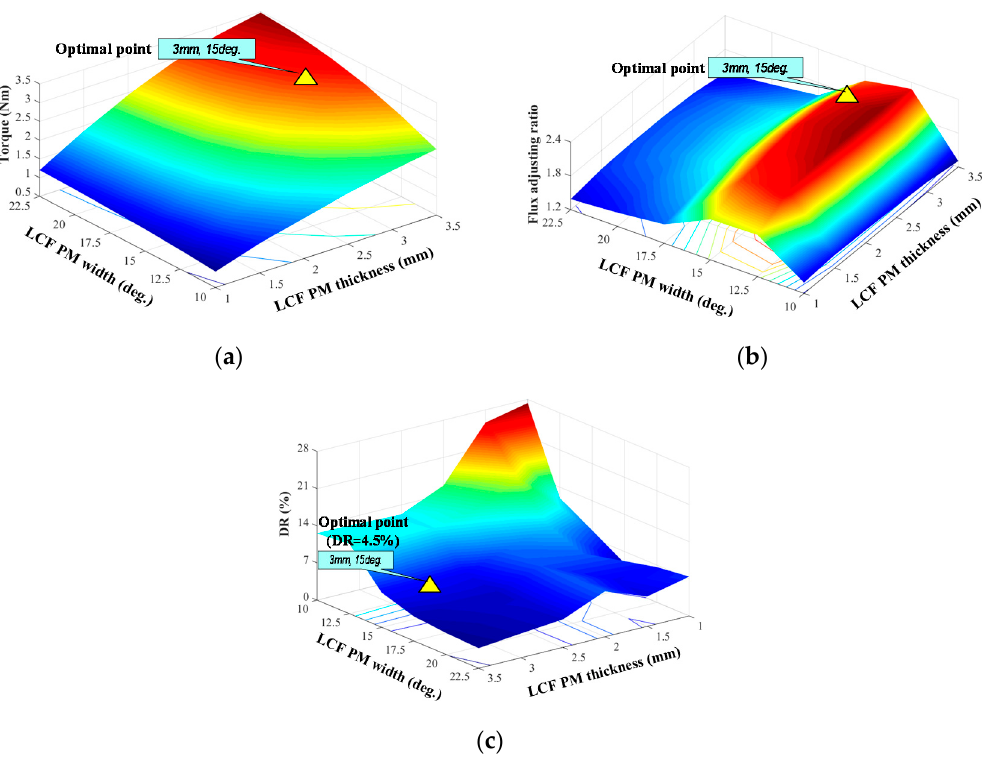
Figure 9. Variations of key electromagnetic characteristics with various PM dimensions, I d = 0, copper loss = 30 W. ( a ) Torque; ( b ) Flux adjusting ratio; ( c ) Demagnetization ratio.